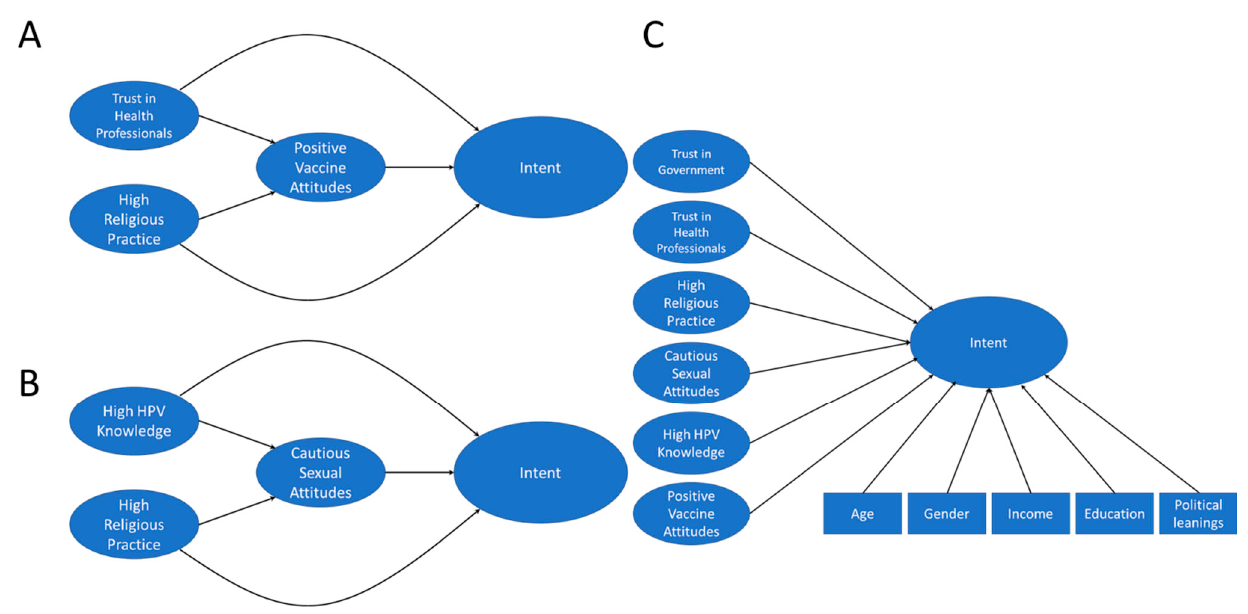
Figure 2. Hypothetical structural models: ( A ) We hypothesize that trust in health professionals and